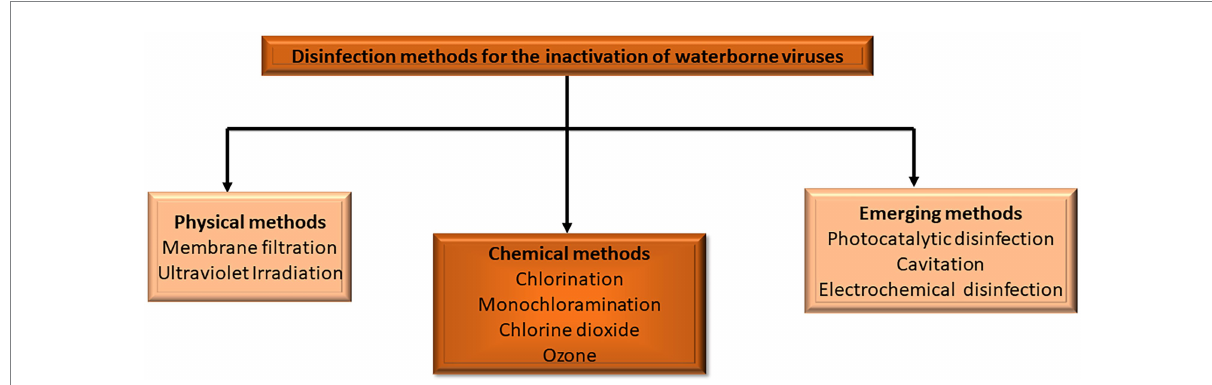
FIGURE 1 Disinfection methods for the inactivation of waterborne viruses (adapted from Chen et al.,